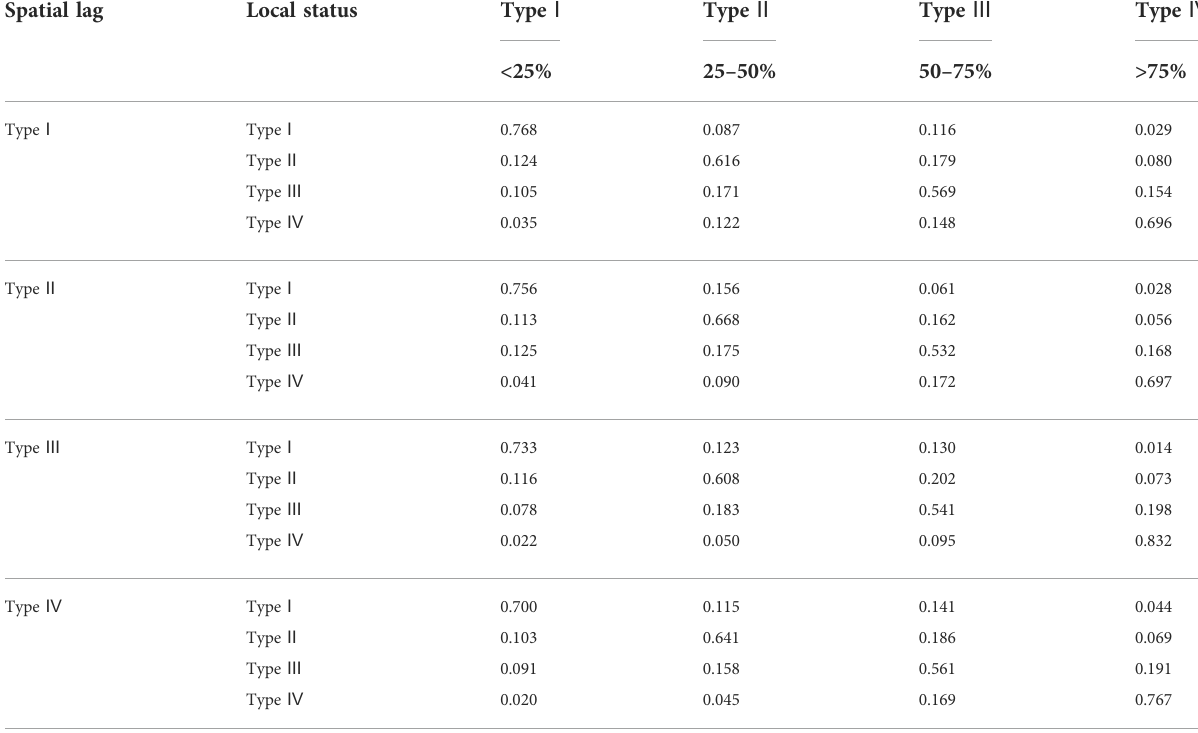
TABLE 4 Markov chain probability transition matrix of the eco-ef fi ciency of RED in the study area. Spatial